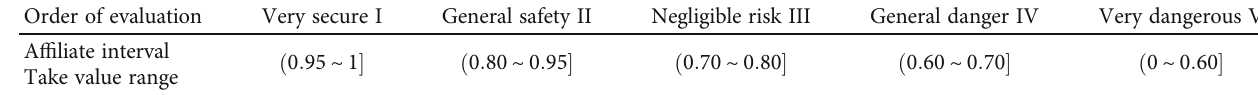
Table 2: Classi fi cation of unsafe behavior in aging mines.